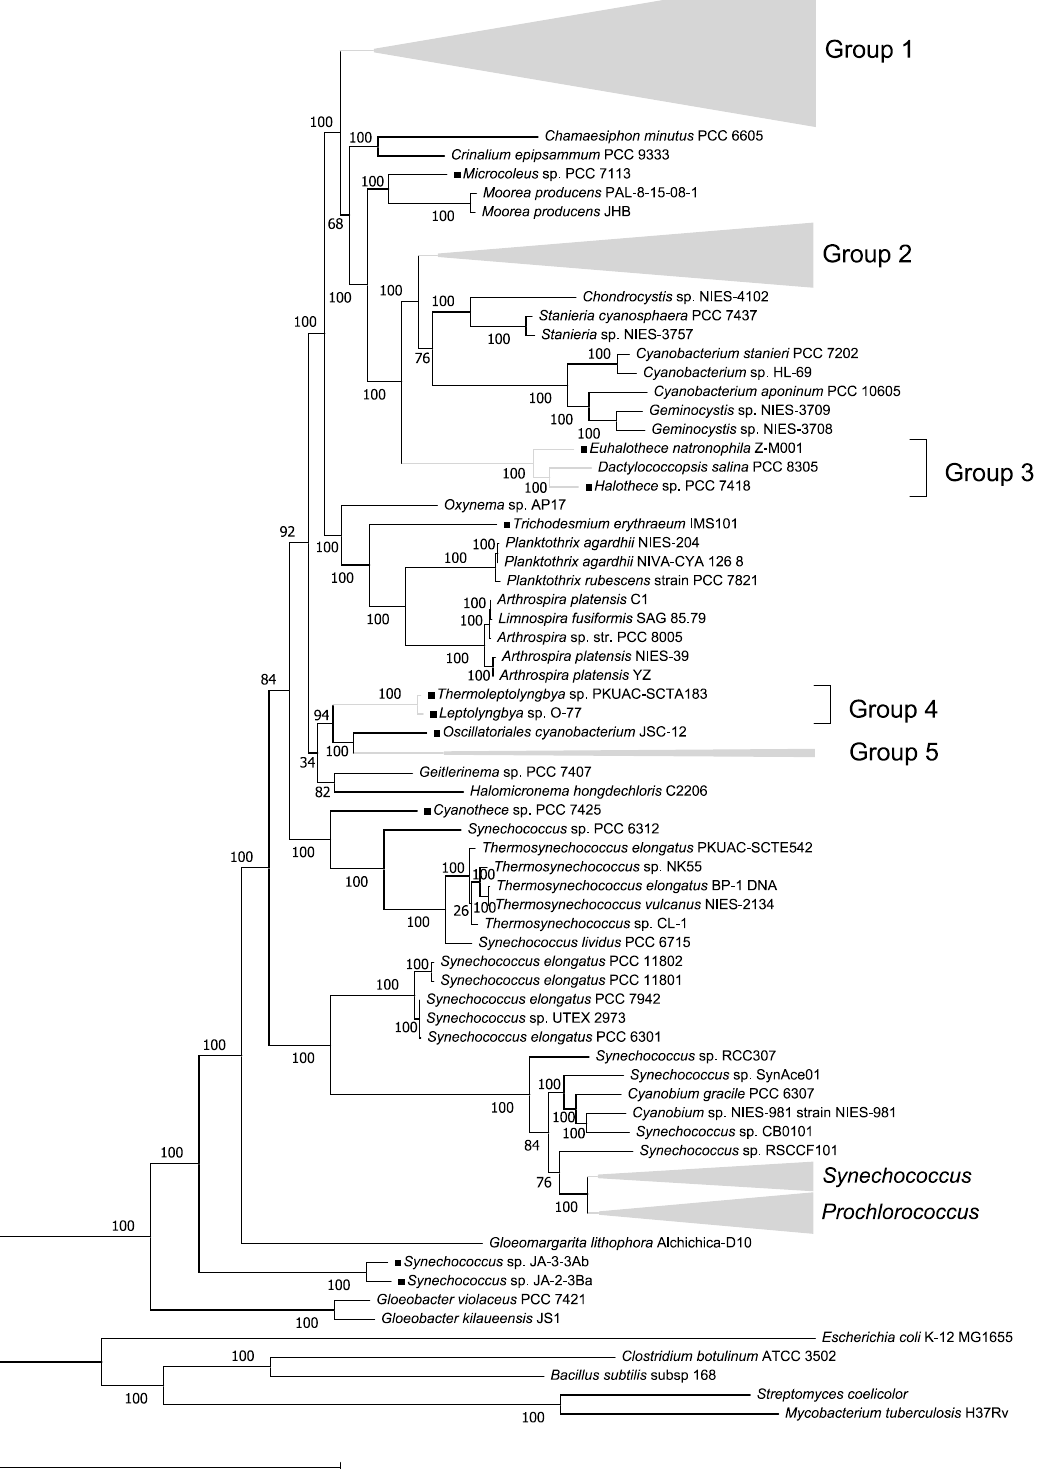
Figure 1. Phylogenetic tree of 179 Cyanobacteria species. The phylogenetic tree was inferred using the concatenated sequences. Some of the phylogenetic relationships among species are compressed in Figure 1, but the complete phylogenetic tree is shown in Figure S1. Black squares indicate diazotrophic Cyanobacteria. Diazotrophic Cyanobacteria belonging to groups I–V are shown in brackets. Diazotrophic cyanobacteria with no closely related species were not included in the groups. Bootstrap values are shown at the internal branches (<100).